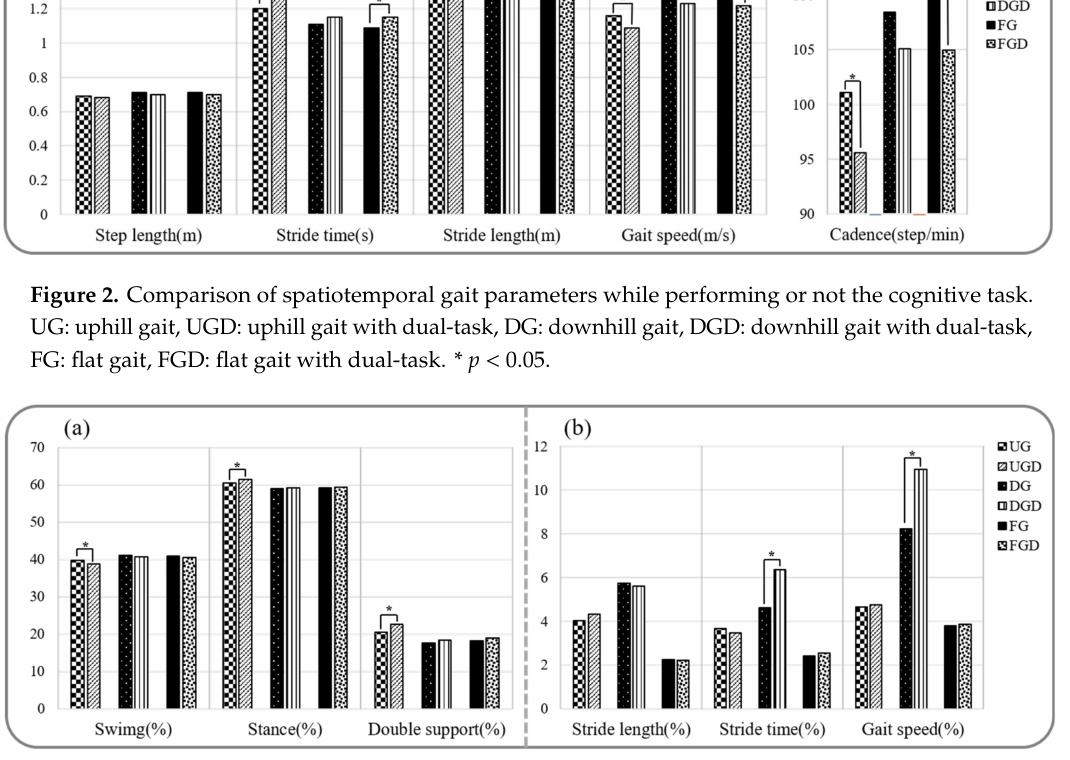
Figure 3. Comparison of spatiotemporal gait parameters and gait variabilities while performing or not the cognitive task. ( a ) Comparison of spatiotemporal gait parameters. ( b ) Comparison of gait variabilities. UG: uphill gait, UGD: uphill gait with dual-task, DG: downhill gait, DGD: downhill gait with dual-task, FG: flat gait, FGD: flat gait with dual-task. * p <